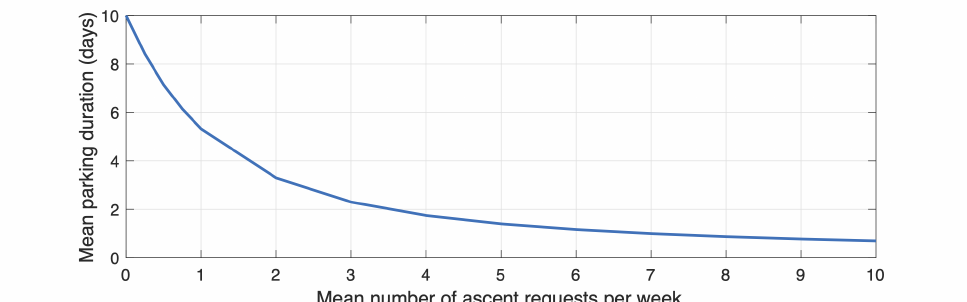
Figure 6. Mean parking duration in function of the mean number of ascent requests for a default parking duration of 10